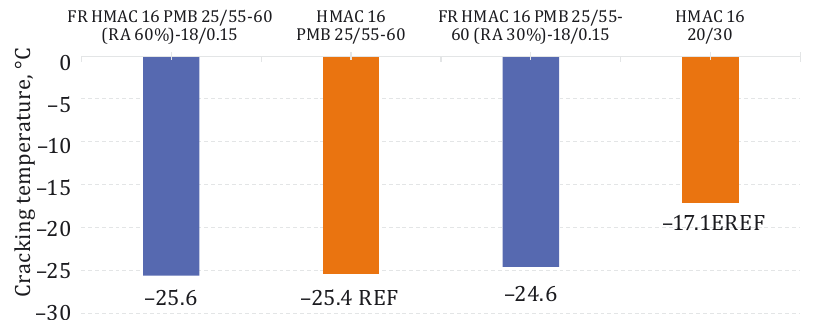
Figure 3. Low-temperature cracking performance results for the base